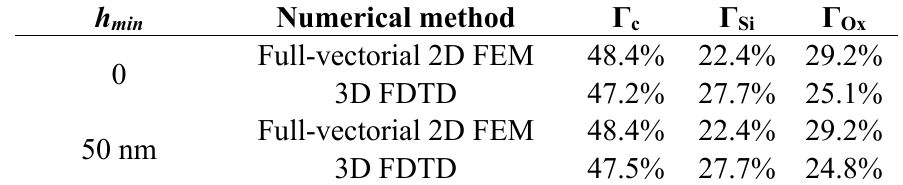
Table 4. Comparison between 3D FDTD and 2D Full-vectorial FEM calculated power confinement factors, for h equal to 0 and 50 nm, min